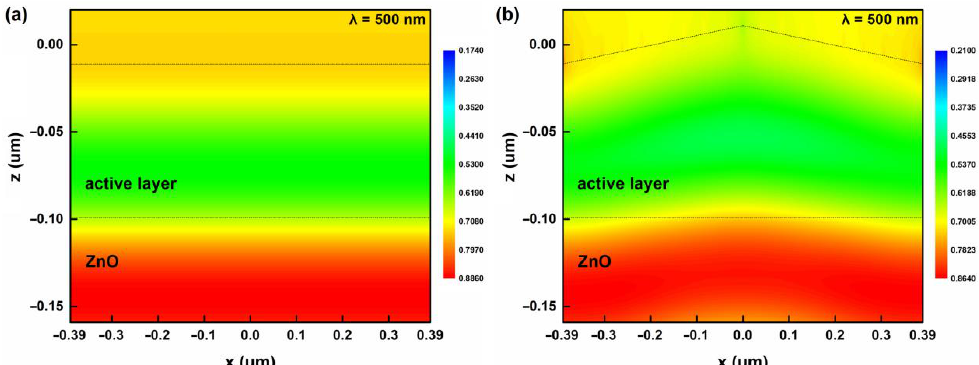
Figure 4. The normalized cross-section near-field profiles of TM-polarized light for normal-incidence monochromatic illumination at the wavelength of 500 nm in the blend films with ( a ) flat and ( b ) textured surfaces.